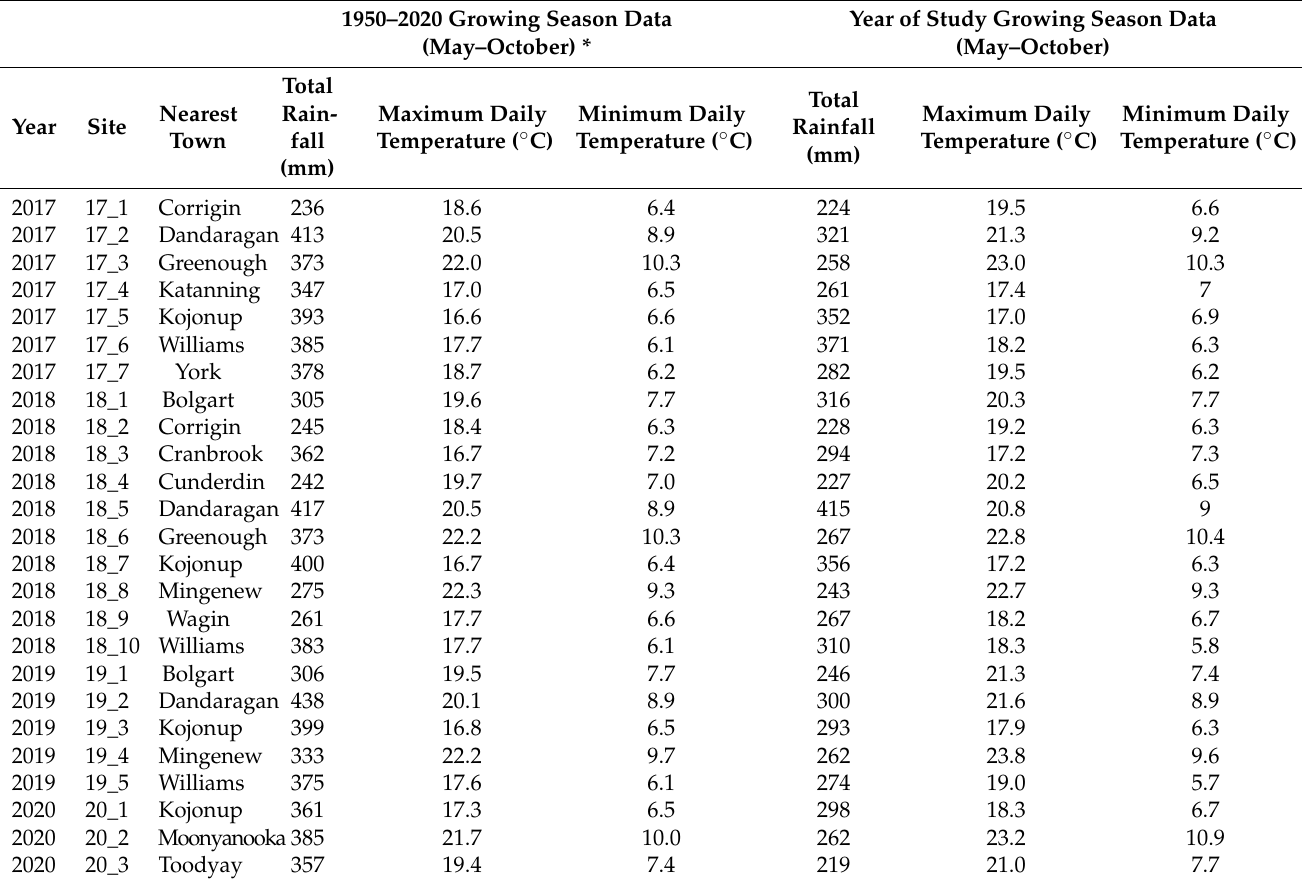
Table 2. Average long-term and study year meteorological data for each field